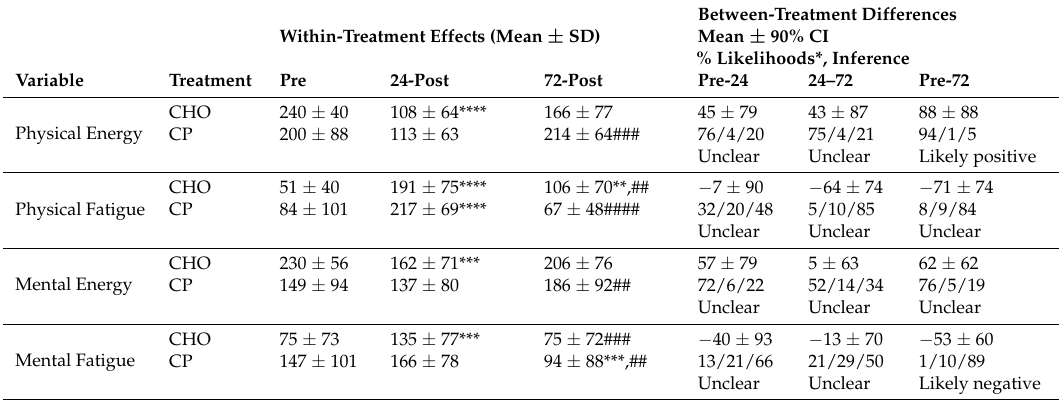
Table 2. Energy/Fatigue Ratings with Protein Supplementation during Exercise (Study